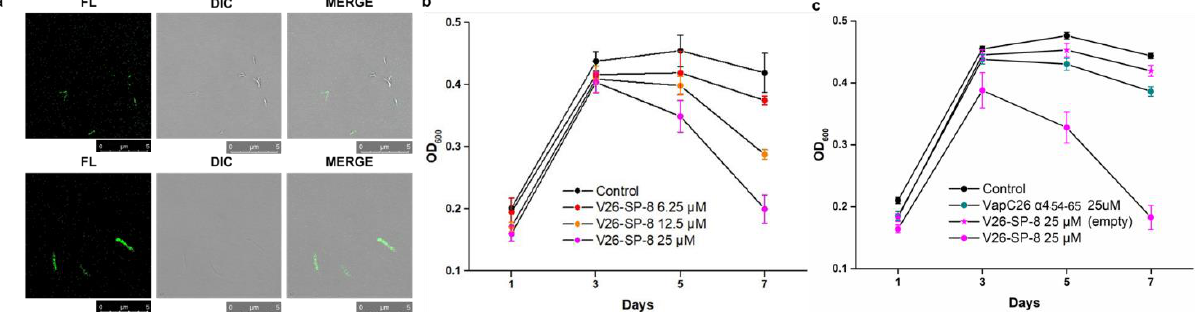
Figure 4. Confocal laser scanning microscopy detection of cell-penetrating peptides in living cells and the growth assay. Fluorescein-only (left) and brightfield images of M. smegmatis (middle) and overlaid images (right) are presented. ( a ) Confocal images of VapC26 α4 54–65 (upper) and V26-SP-8 (lower). Similar results were obtained in two independent experiments. ( b , c ) Error bars represent the standard error of the mean of three biological replicates. ( b ) M. smegmatis growth assay with V26-SP-8 at different concentrations. ( c ) Growth assay including empty vector harboring M. smegmatis using V26-SP-8 and VapC26 α4 54–65 at 25 μM.